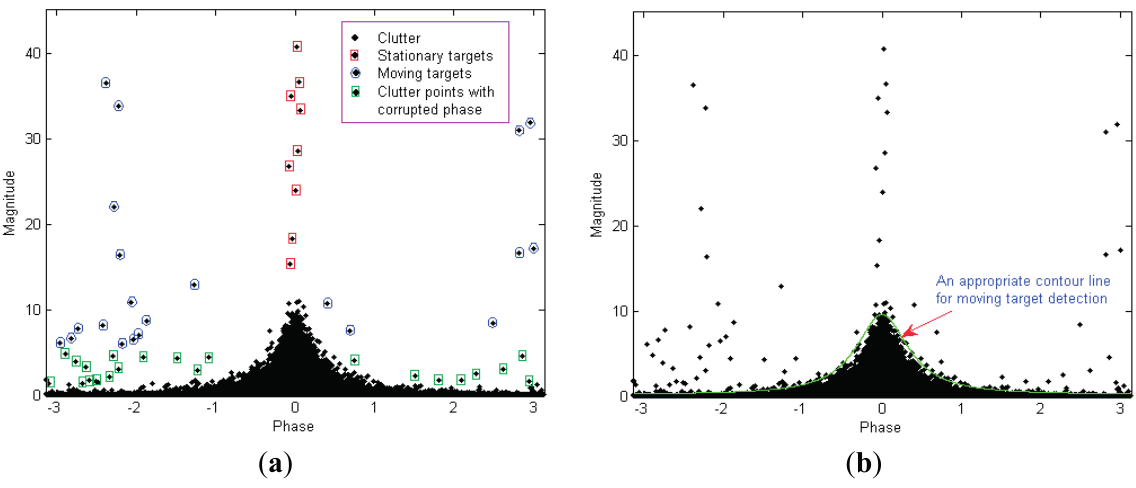
Figure 2. The magnitude-phase (M-P) plane: ( a ) Magnitude vs. phase of SAR ATI signals: the moving target points whose phases are less than 0 belong to the target labeled 1 in Figure 1a; the moving target points whose phases exceed 0 belong to the target labeled 2 in Figure 1a; the stationary target points belong to the target labeled 3 in Figure 1a; ( b ) Sketch of the proper contour line to be used as the detection